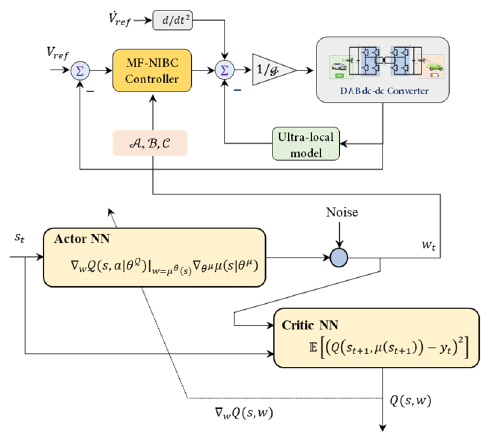
Figure 5. Structure of MF-NIB controller designed by the DDPG algorithm.